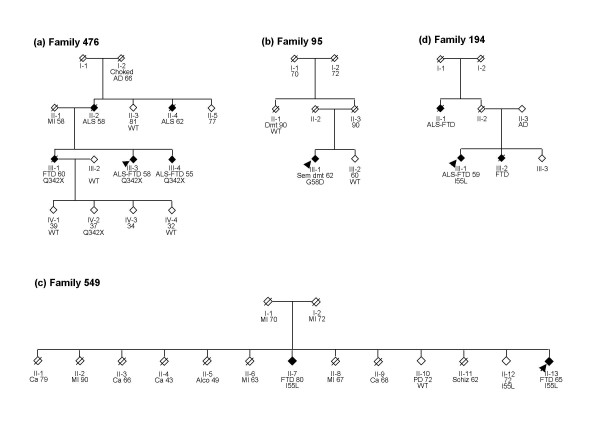
Family 476, 95, 549 and 13 originate from North America. WT indicates a mutation-negative subject, Q342X, G58D and I55L indicate subjects carrying a heterozygous sequence variation. Currently unaffected mutation carriers have not been shown; in all instances these individuals have not yet reached the maximum age at onset observed.